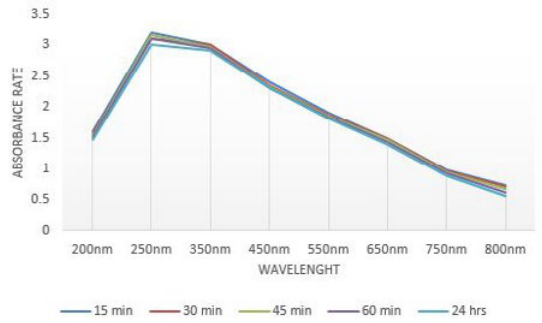
Fig. 2. Peak absorbance of Nickel oxide Nano particles at 250 nm Fig 2. Peak absorption of Nickel oxide Nano particles at